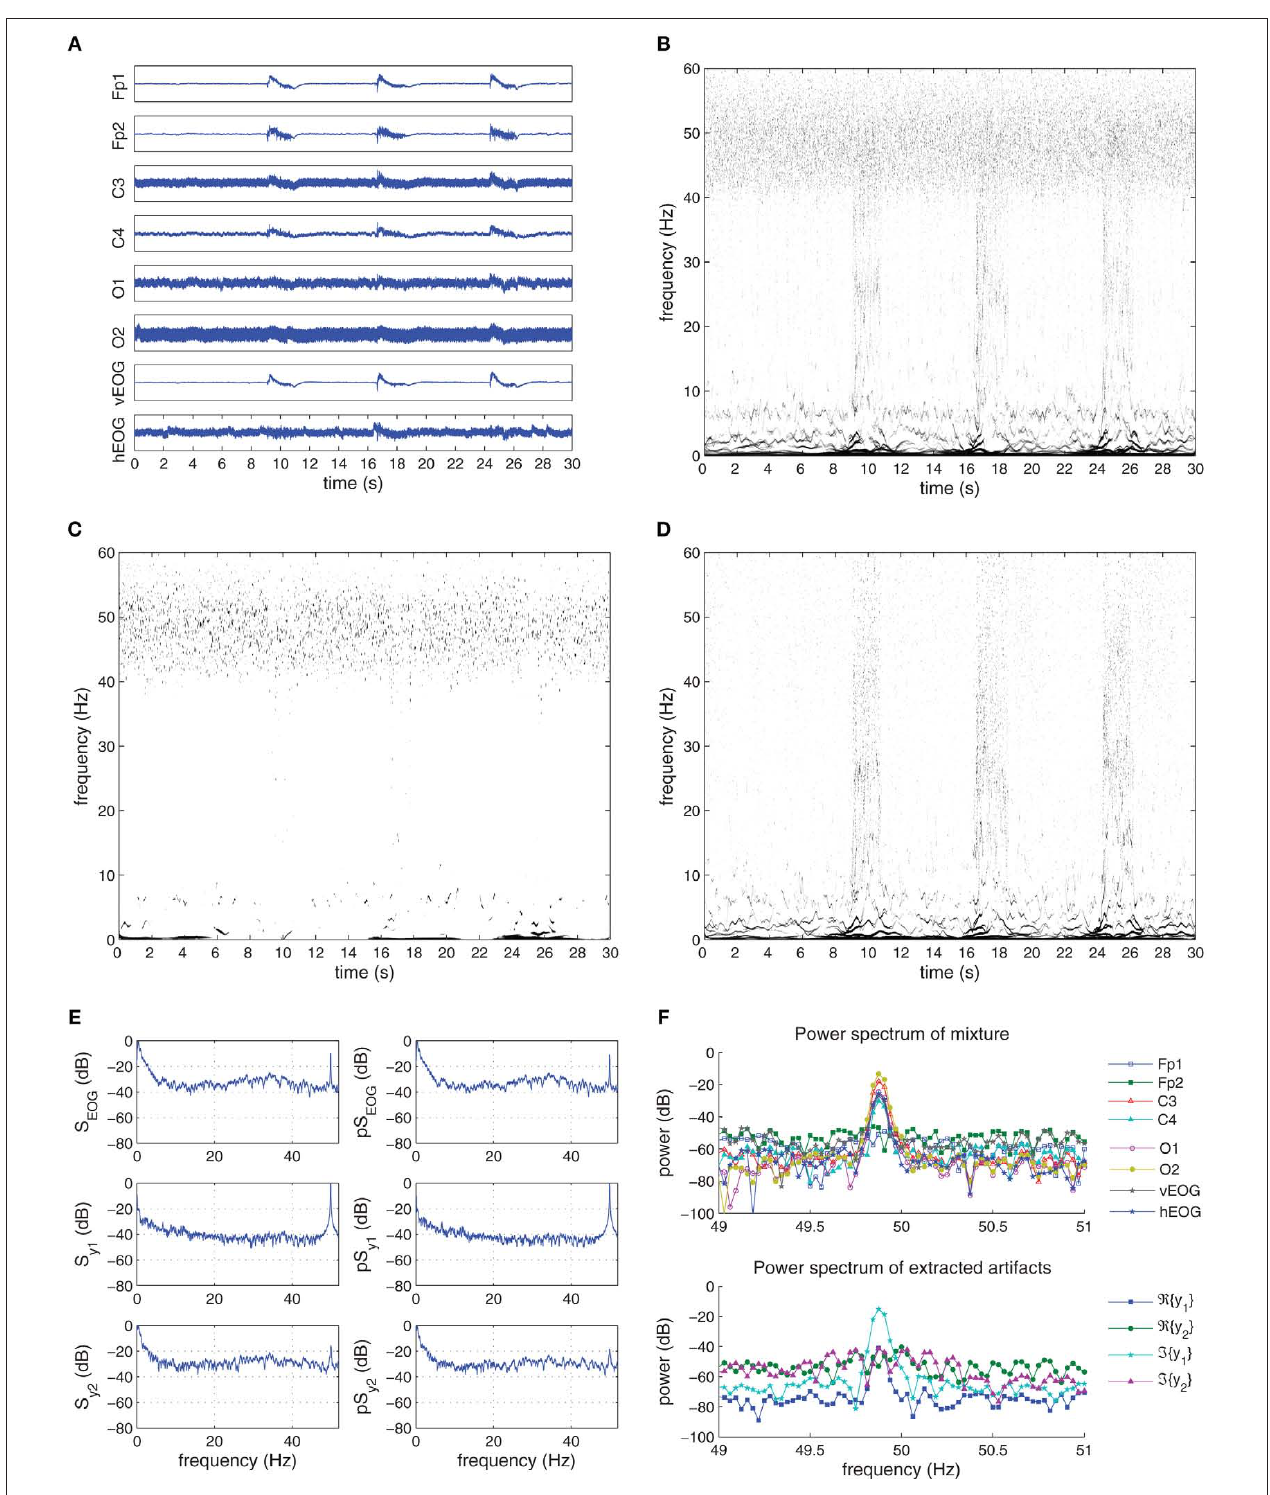
FiGurE 12 | recorded and extracted artifacts from the “ E yEbrow ” set. (A) Recorded EEG signals from the “ E yEbrow ” set. (B) The Hilbert– Huang time–frequency plot of the recorded EEG signals. (C) The Hilbert– Huang time–frequency plot of the extracted line noise I { y Hilbert–Huang time–frequency plot of the extracted EMG R { y